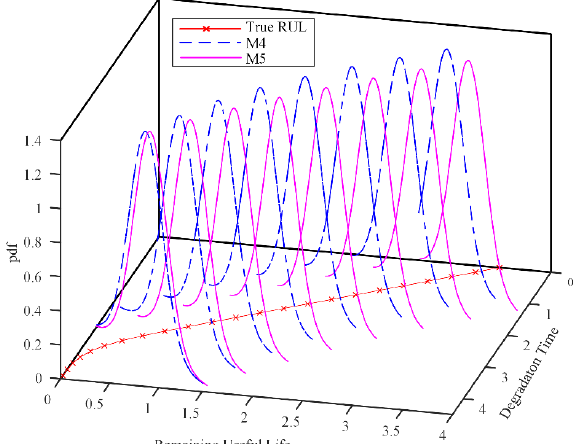
Figure 8. RUL PDF for different models.